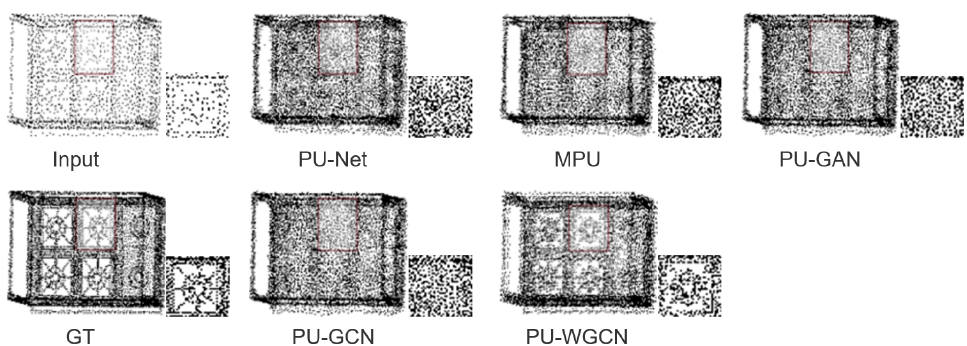
Figure 15. Upsampling visualization results of group e. PU-WGCN preserves the hole information of